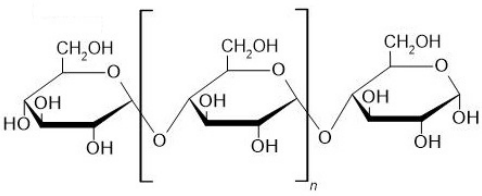
Figure 1. The general structure of maltooligosaccharides.